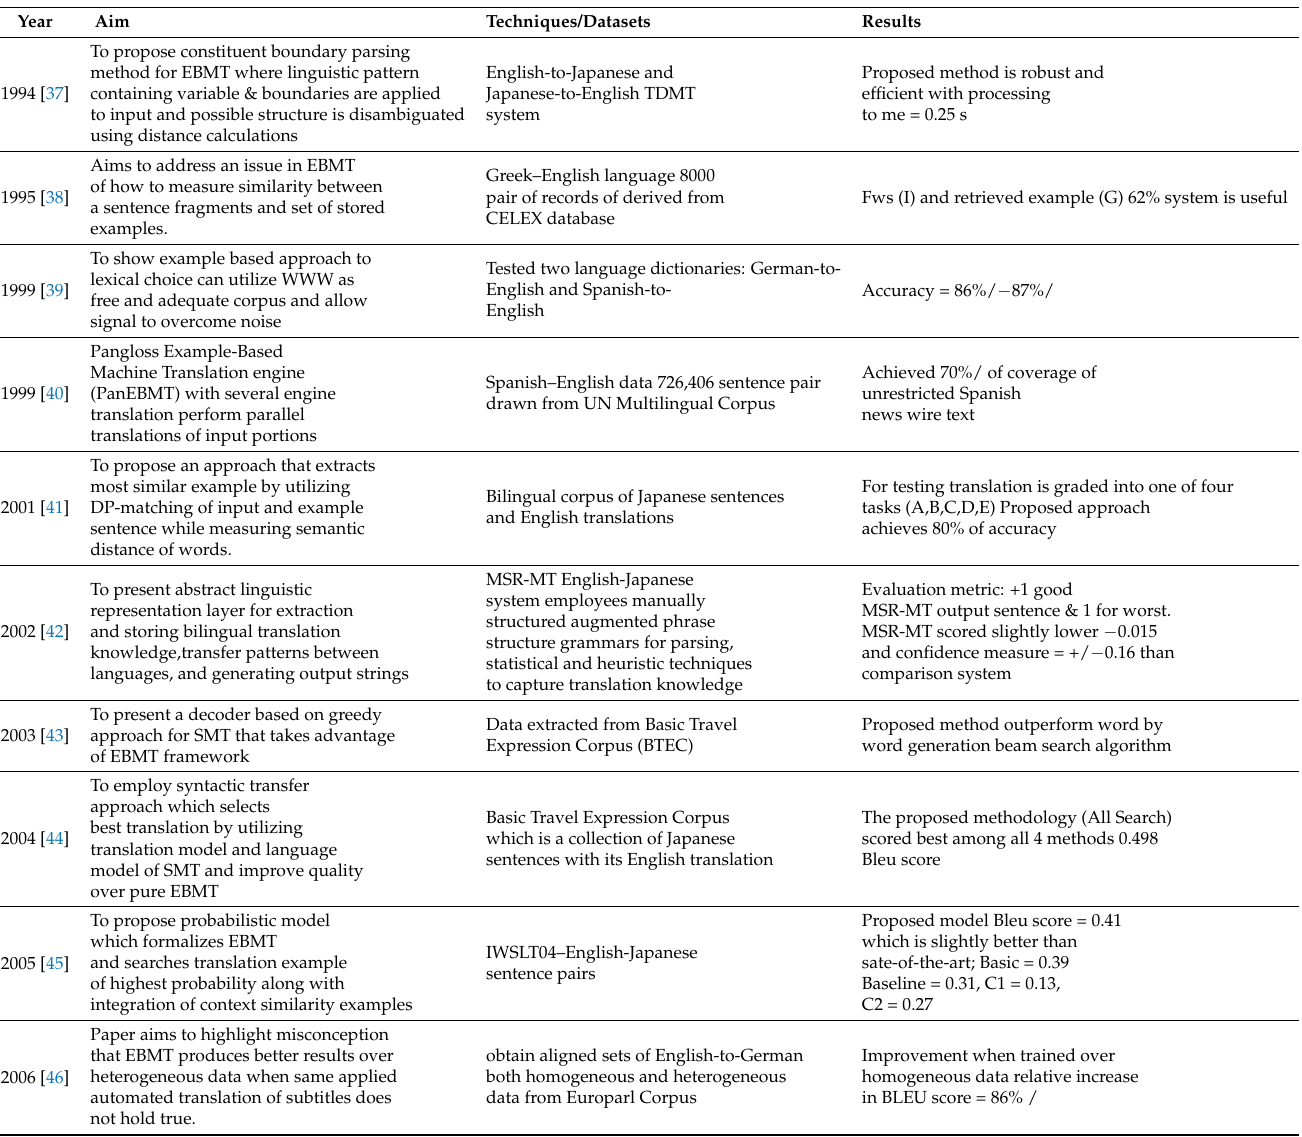
Table 1. Survey for example-based machine